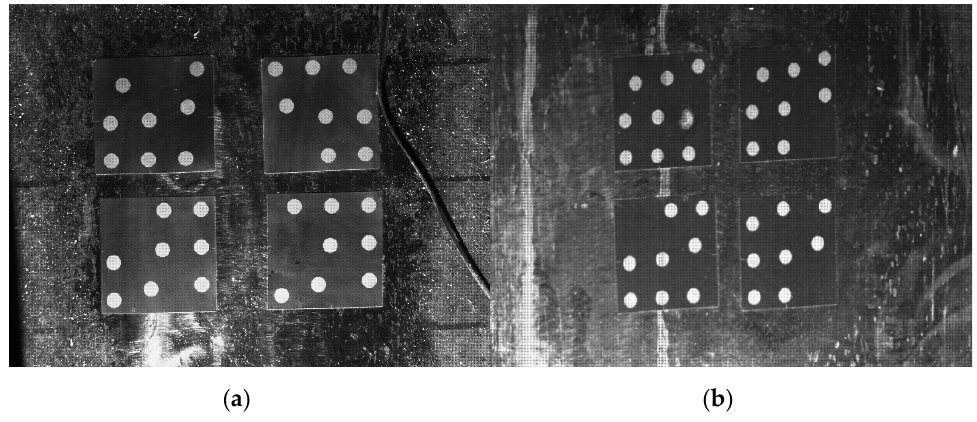
Figure 4. Distribution of the targets that was used for: ( a ) Truss A; ( b ) Truss B.